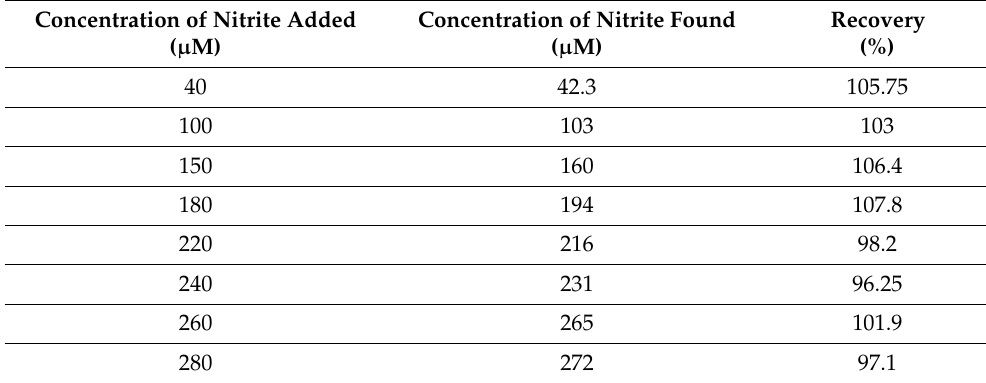
Figure 11. Constant potential chronoamperogram for adding different nitrite concentrations in the Nile River water at pH =7 and constant potential of 1.0 V. Table 4. Real sample electrochemical detection of nitrite in the Nile River water. Concentration of Nitrite Added Concentration of Nitrite ( µ M)